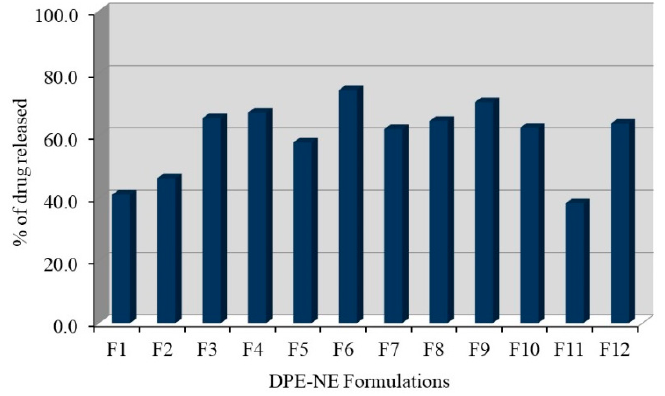
Figure 3. Representing DPE in vitro Release study from different NE formulations in phosphate buffer pH 7.4 at 37 °C. Results are stated as the mean ± SD of three experiments.